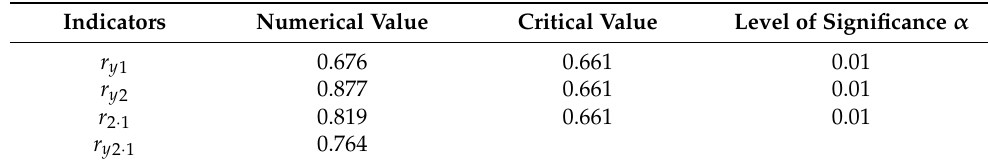
Table 4. Statistics of Relevant